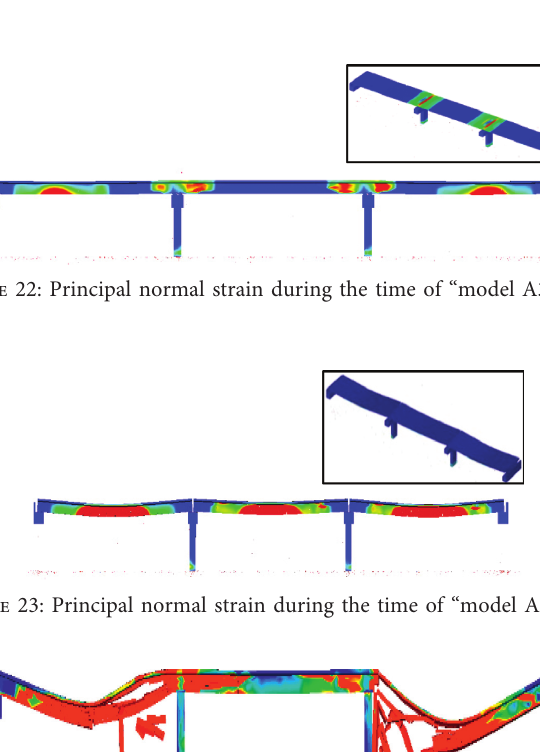
Figure 21: (a) 2D view of the principal normal strain during the time history “model A3-M-K.” (b) 3D view of the principal normal strain during the time history “model A3-M-K.”